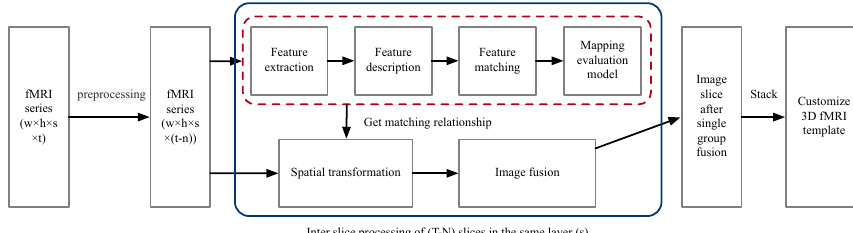
Figure 1. Custom fMRI template construction